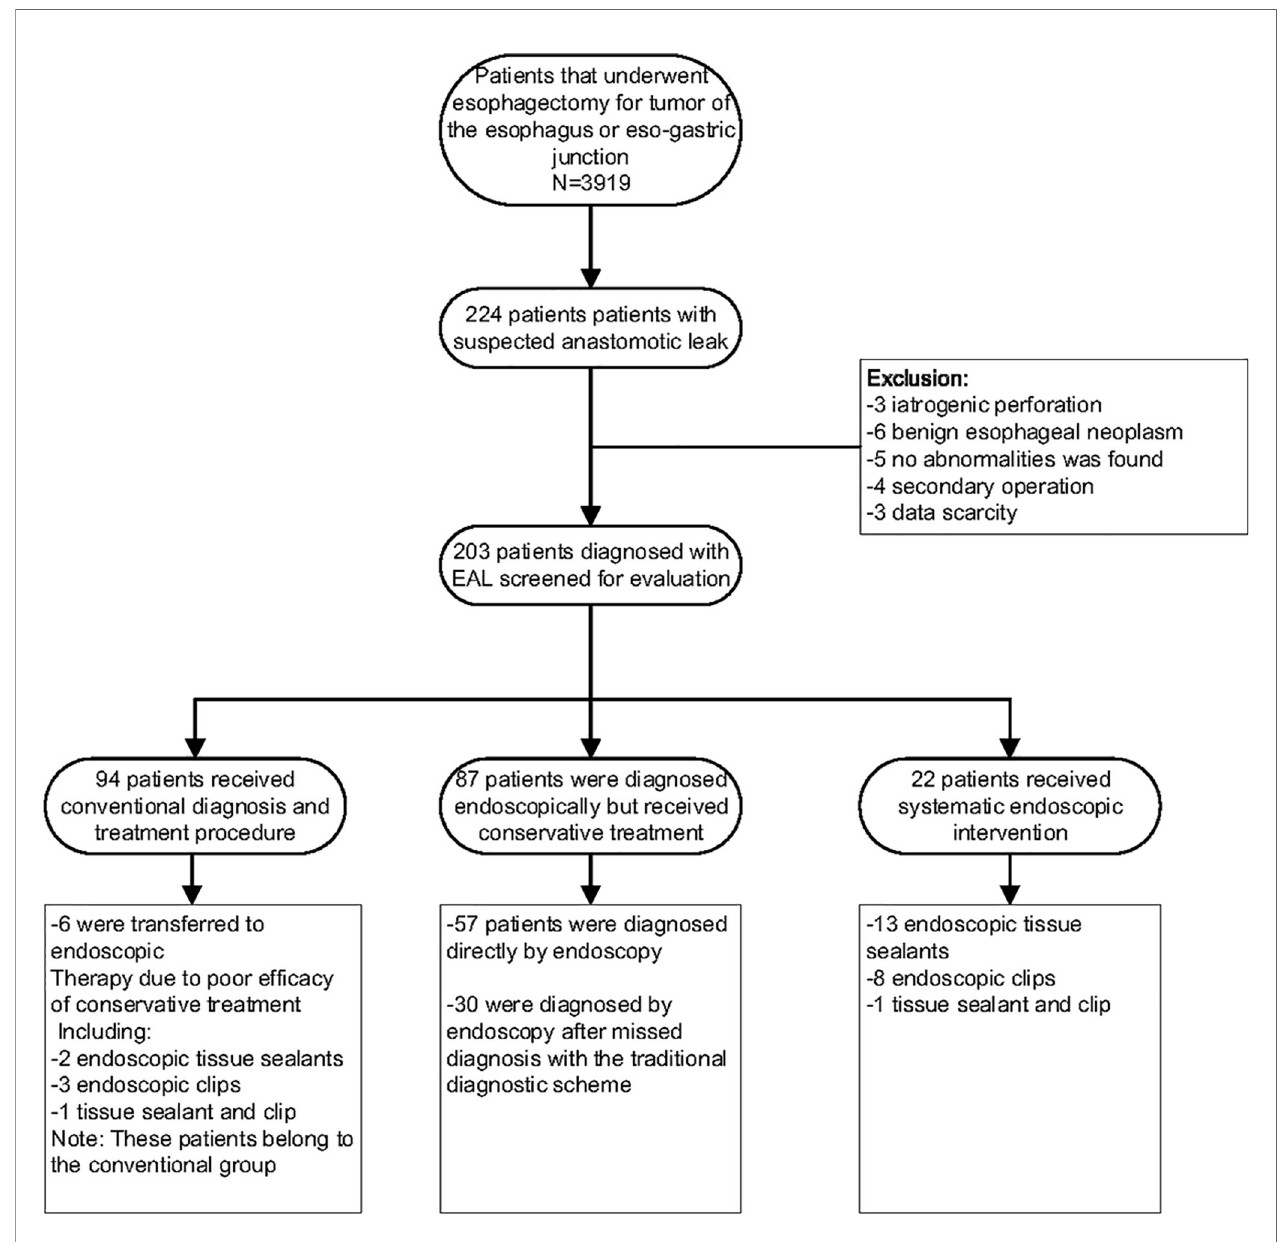
FIGURE 1 | Description of the selection of the studied population of